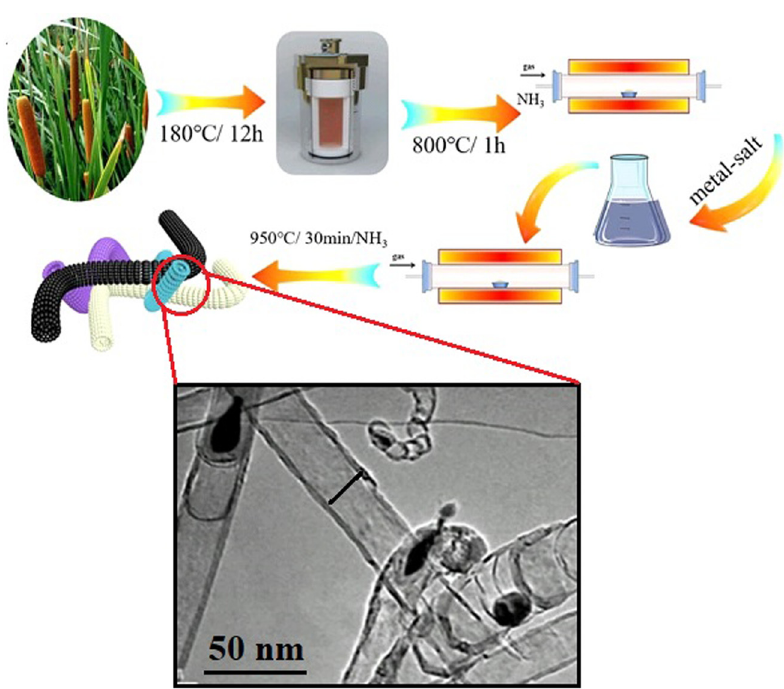
Figure 5: Schematic of the preparation of CNTs with corresponding particle size determination using high resolution transmission electron microscopy ( HRTEM ) imaging [ 371 ]